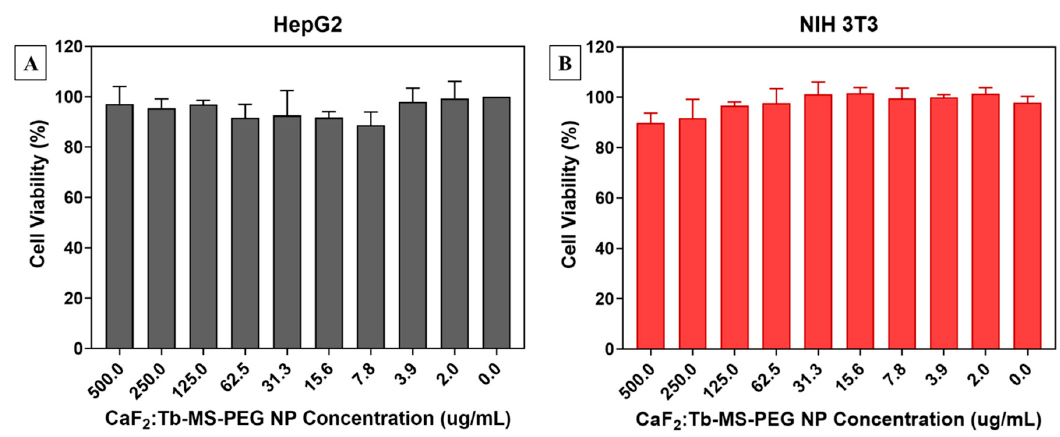
Figure 5. Cell viability assays of ( A ) HepG2 and ( B ) NIH 3T3 cell lines after incubation with various concentrations of CaF 2 :Tb-MS-PEG NPs for 24 h.